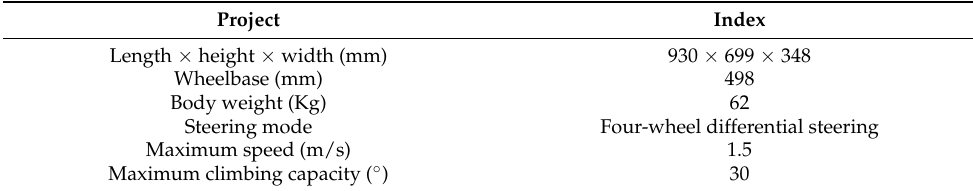
Figure 1. The schematic diagram of the robot architecture. ( a ) Robot chassis and ( b ) working device. Table 1. Physical parameters of the seeding